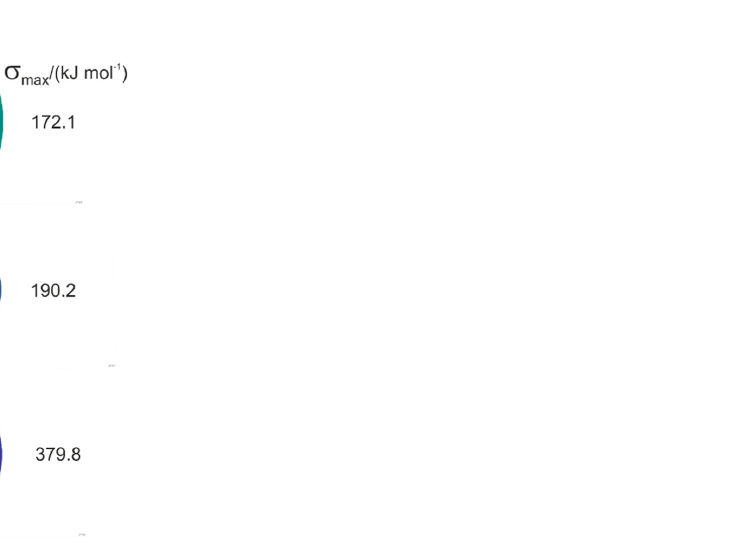
Figure 3. D e plotted against N B for each series B···CuF, B···CuCl, B···AgF, B···AgCl, B···AuF, and B···AuCl, where B = N 2 , CO, C 2 H 2 , C 2 H 4 , PH 3 , H 2 S, HCN, H 2 O, and NH 3 . Each straight line is a linear regression fit to the set of points for the associated B···M–X.